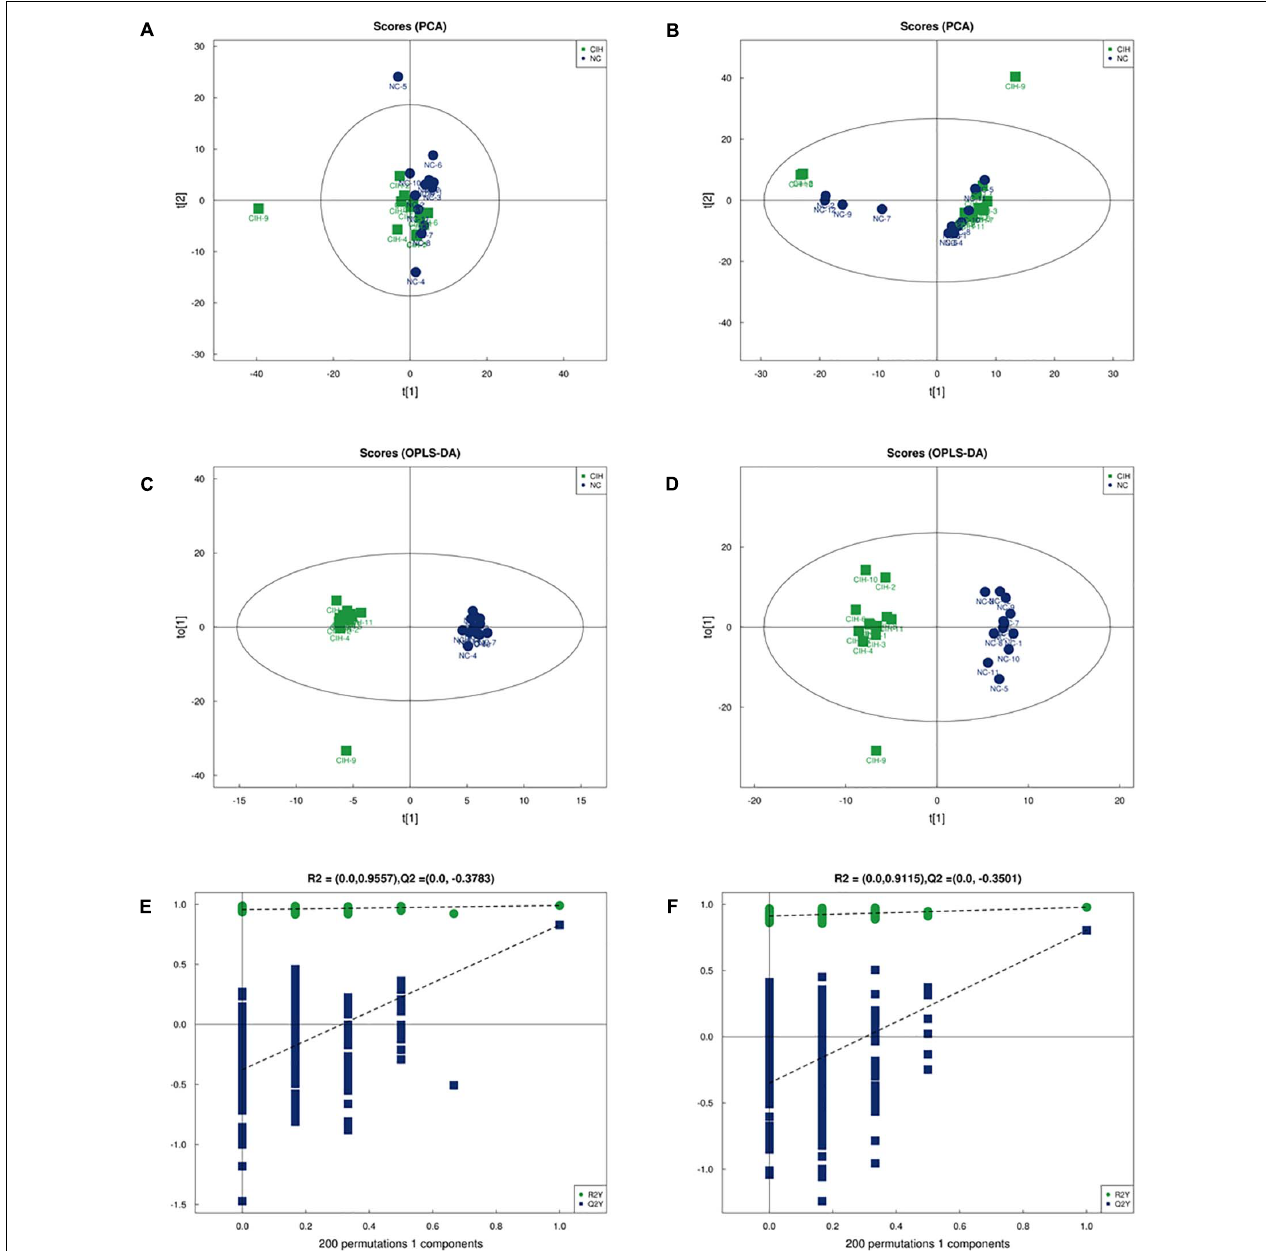
FIGURE 2 | Multivariate analysis of UHPLC-Q-TOF/MS data (A) Score plot of PCA in positive ion mode ( R 2 X = 0.546) and (B) negative ion modes ( R 2 X = 0.579). (C) Score plot of OPLS-DA in positive ion mode ( R 2 X = 0.506, R 2 Y = 0.99, and Q 2 = 0.828) and (D) negative ion mode ( R 2 X = 0.614, R 2 Y = 0.978, and Q 2 = 0.804). (E) Permutation test results of the OPLS-DA model in the positive ion mode and (F) negative ion mode. The Q 2 -value represents the predictability of the model. The R 2 Y value represents the goodness of fit of the model. All R 2 Y and Q 2 values to the left are lower than the original points to the right, suggesting that the OPLS-DA model is